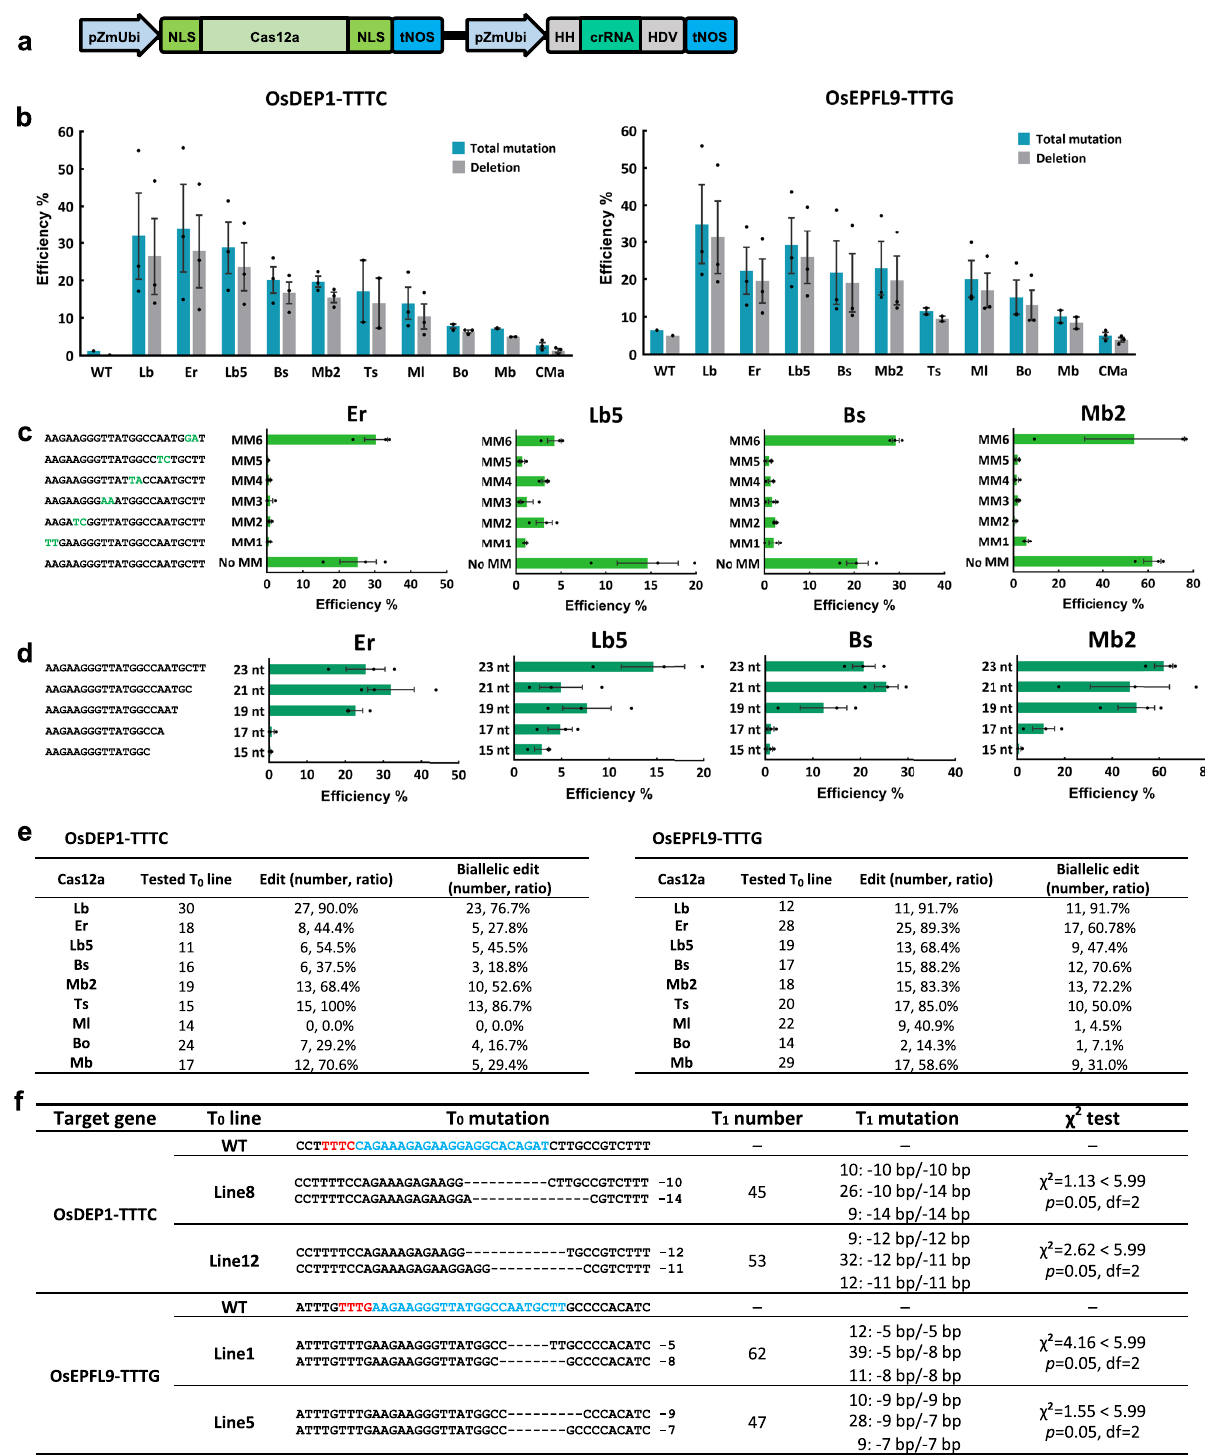
Fig. 1 Targeted mutagenesis by Cas12a orthologs at canonical TTTV PAM sites in rice. a A schematic diagram of the Cas12a expression system for single site targeting. pZmUbi maize ubiquitin promoter, NLS nuclear localization signal, tNOS nopaline synthase (NOS) terminator, HH hammerhead ribozyme, HDV hepatitis delta virus ribozyme. b Targeted mutagenesis ef fi ciencies (percentage) of ten Cas12a orthologs at two TTTV PAM sites in rice protoplasts. WT, protoplasts transformed with water. c Targeting speci fi city of four Cas12a orthologs measured with mismatched crRNAs at the OsEPFL9-TTTG site in rice protoplasts. Mismatched nucleotides in crRNAs are highlighted in green. d Protospacer length requirements of four Cas12a orthologs at the OsEPFL9-TTTG site in rice protoplasts. e Summary of editing and biallelic editing ef fi ciencies of Cas12a orthologs at two TTTV PAM sites in transgenic rice T 0 lines. f Editing analysis of transgenic rice T 1 lines. χ 2 test results indicate that T 1 populations from each tested T 0 line segregated at a 1:2:1 ratio when α = 0.05. Data in “ b – d ” are presented as mean values ± SEM. n = 3 biologically independent samples. Source data are provided as a Source Data fi le.